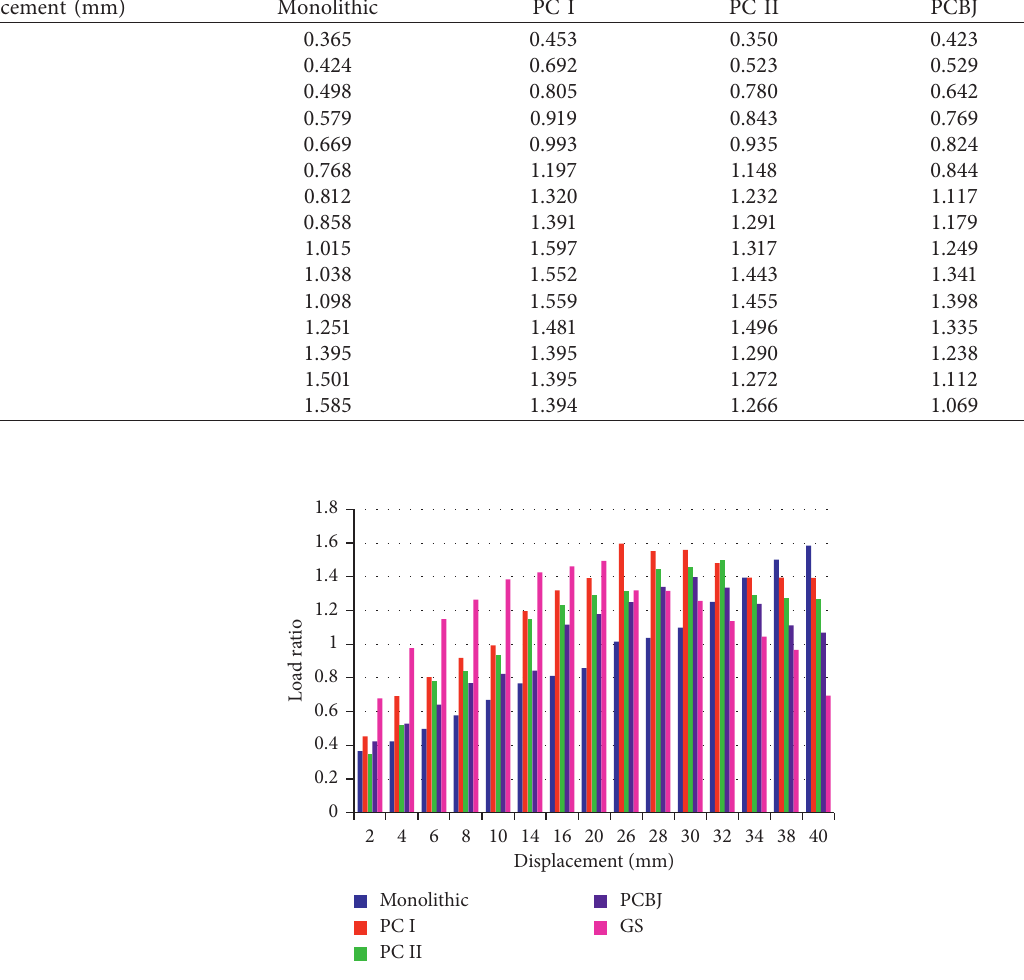
Figure 15: Comparison of load ratio of all specimen.